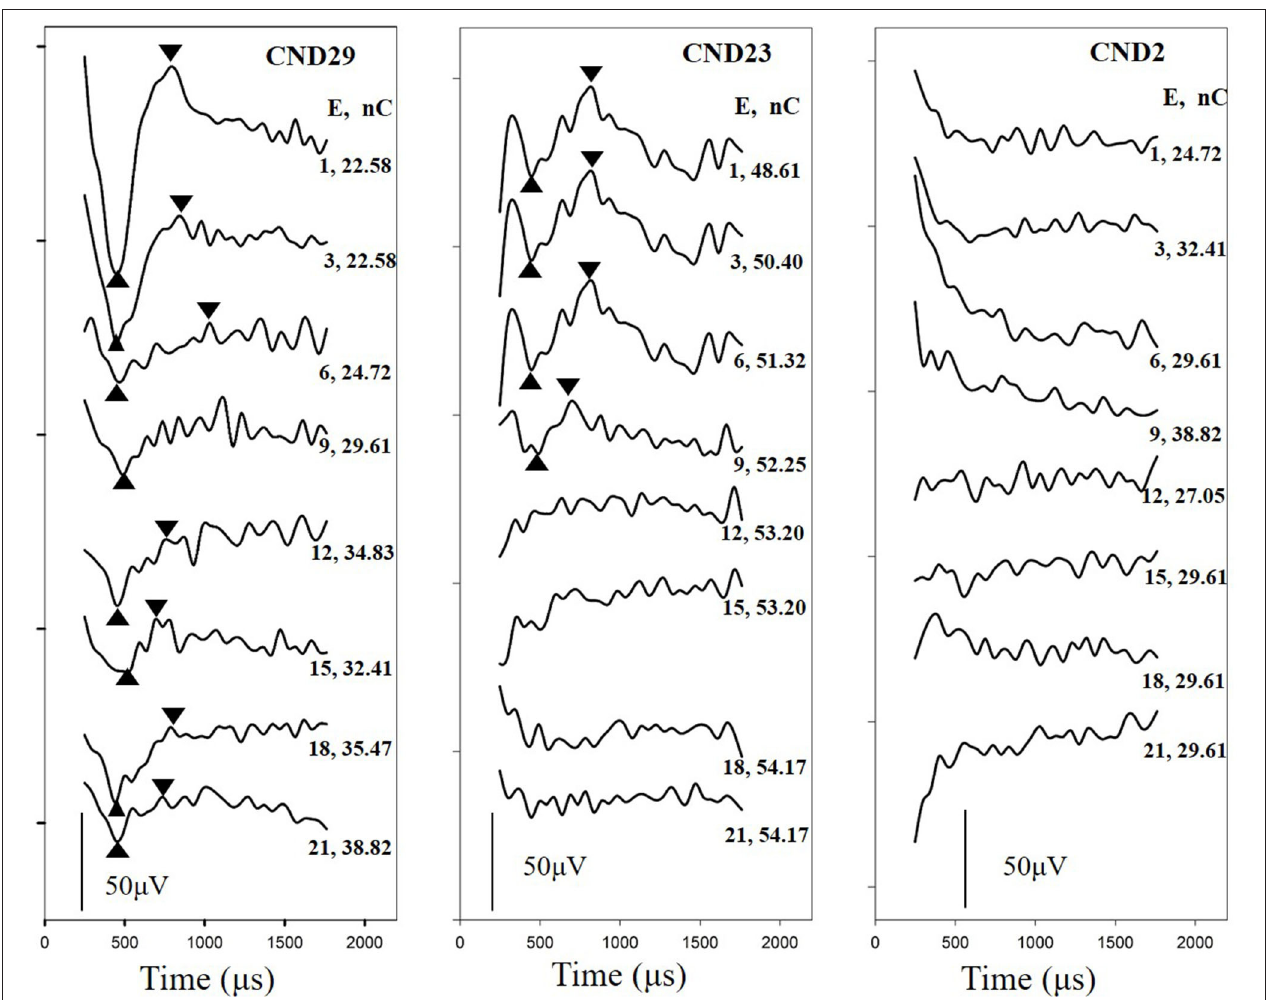
FIGURE 2 | Waveforms of ECAP responses were recorded from multiple electrodes in three children with cochlear nerve aplasia diagnosed based on MRI images. For CND29, the ECAP was recorded from all electrodes; for CND23, the ECAP was recorded from electrodes 1–9; and for CND2, the ECAP could not be recorded from any electrodes. Tested electrodes and stimulation levels are shown on the right of each panel. E, tested electrode; nC, stimulation level; ECAP, electrically evoked compound action potential.